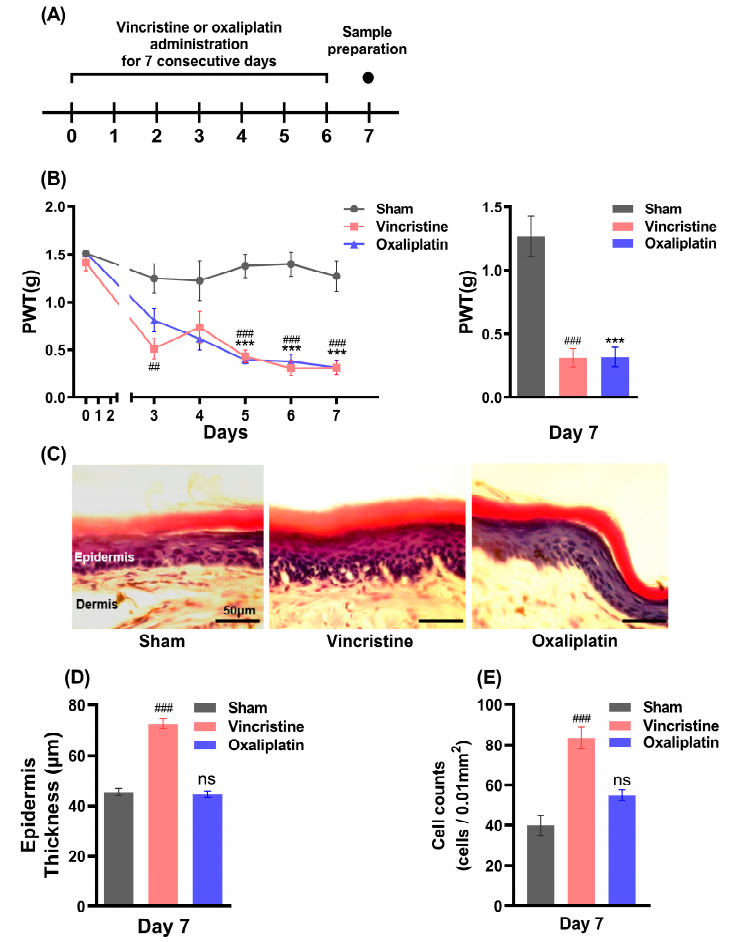
Figure 1. ( A ) Injection scheme to induce CIPN. ( B ) PWT measured for mechanical allodynia test using von Frey filament and PWT on the 7th day of the experiment (n = 5). ( C ) Histology of hind paw skin of a mouse on 7th day; scale bar represents 50 µ m in length (n = 4). ( D ) Epidermal thickness length measured. Vincristine- and oxaliplatin-treated mice were compared to the sham mice. ( E ) Number of cells counted per 0.01 mm 2 in the epidermis and dermis layer (n = 9). Results are presented as